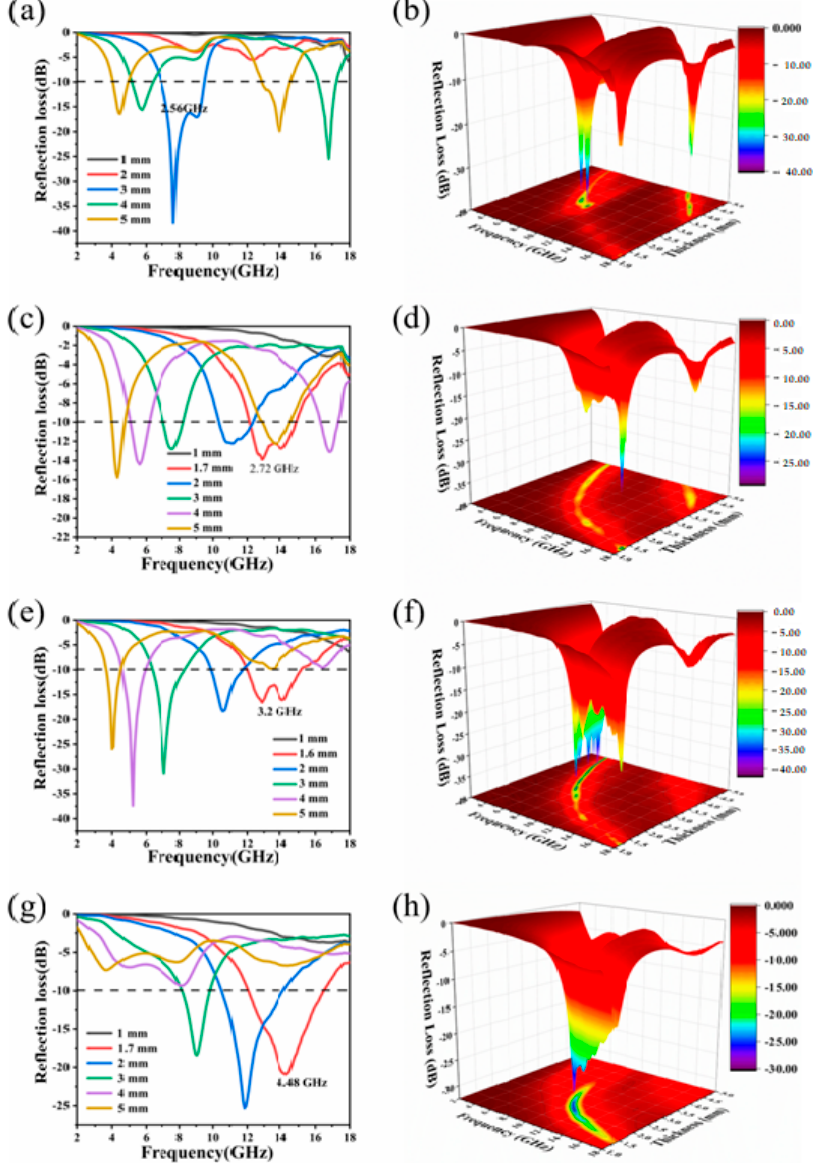
Figure 6. Reflection loss of ( a , b ) CuPc-600, ( c , d ) CuPc-700, ( e , f ) CuPc-800, and ( g , h ) CuPc-900.